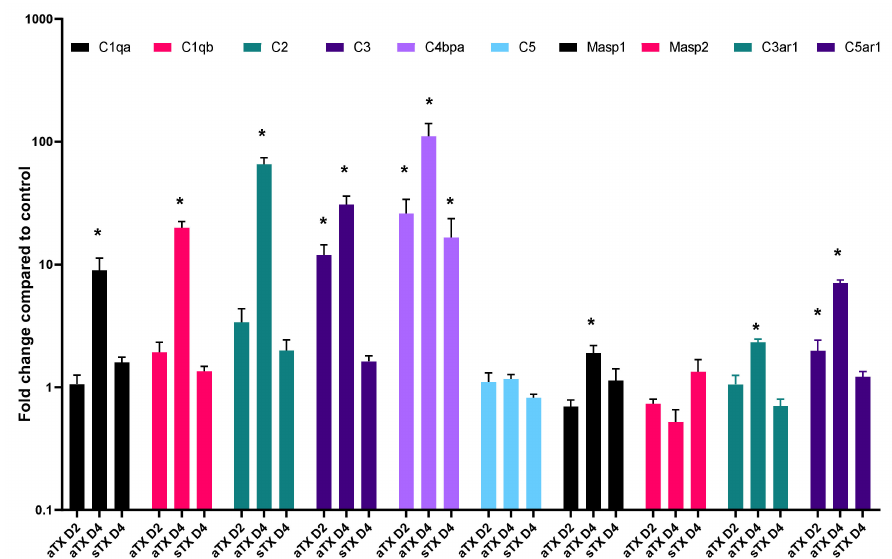
Figure 3. Allogeneic transplantation induces expression of complement components. The mRNA expression of selected members of the complement pathway was analysed in kidneys on day 2 after aTX (aTX D2), day 4 after aTX (aTX D4), or on day 4 after sTX (sTX D4) by real-time PCR. The expressions relative to the control kidney were calculated using the 2 − ∆∆ Ct method ( n = 3–5/group). One-way ANOVA was used to calculate significant differences in expression level compared to control kidney ( p < 0.05) and is marked with *.